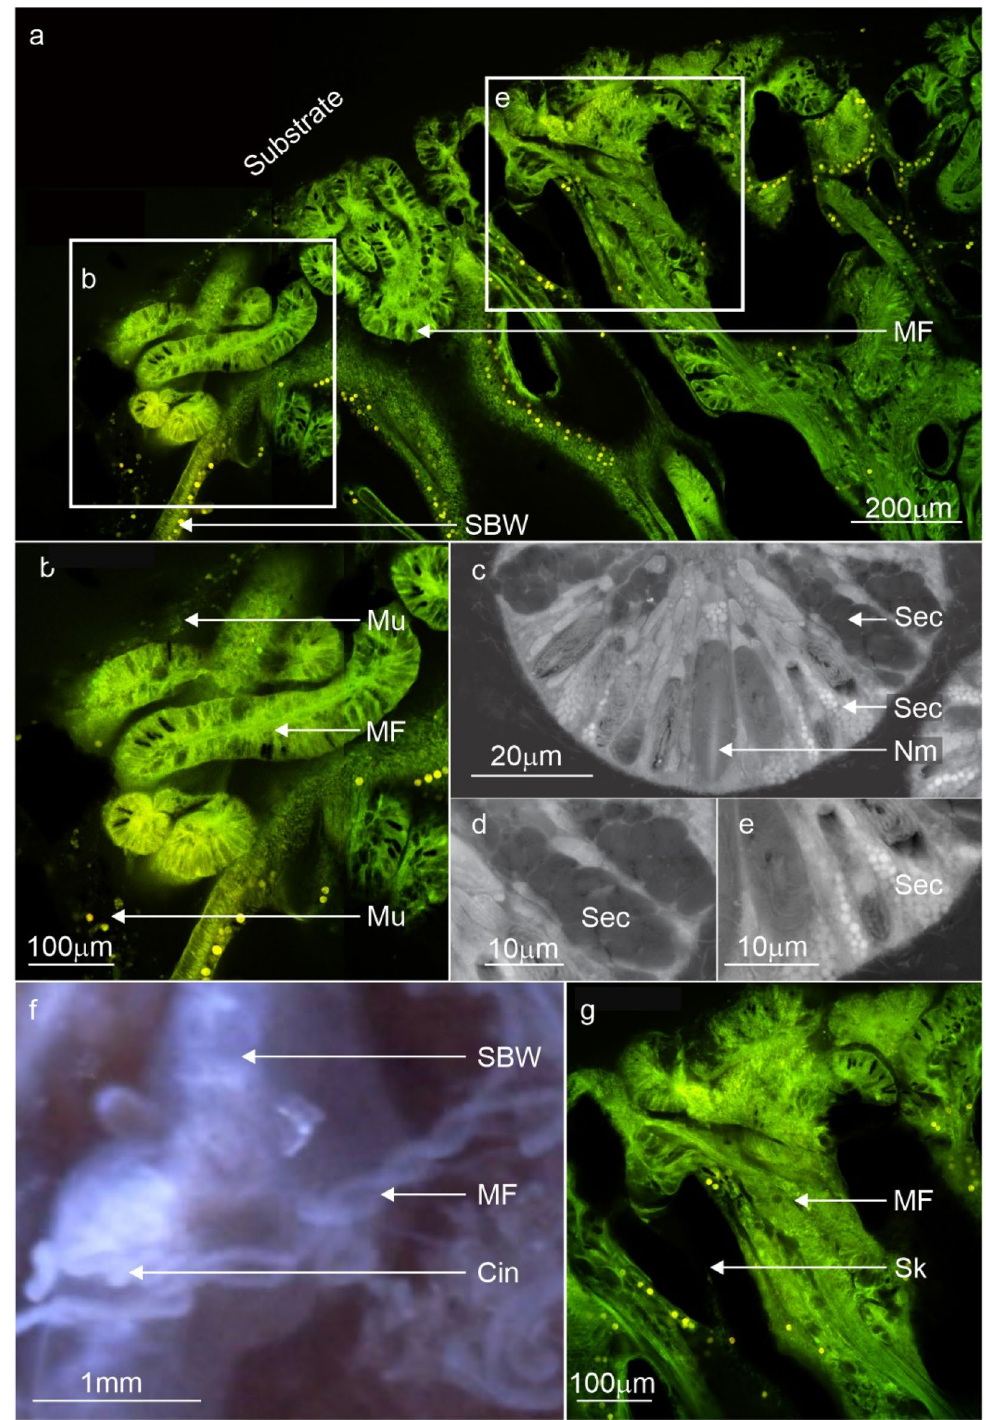
Figure 3. Confocal fluorescence microscopy images, backscatter electron microscopy images and stills from time-lapse microscopy movies highlighting the distribution, cell composition and mesenterial behaviour during the contact response phase. ( a , b ) Contact with the substrate lead to the deployment of mesenterial filaments (MF) in newly formed wounds and the formation of a mucus barrier. ( c – e ) A diverse number of secretory cells (Sec) were present in the mesenterial filaments of A. millepora , and their proximity to the wounds and mucus indicates a role in cleaning and mucus formation. ( f ) For mesenterial filaments to move through the SBW and extend beyond the body cavity, they employ a twisting or corkscrewing motion to slide out of the cinclide- like (Cin) openings (Supplementary Movie S2). ( g ) Fluorescence image of the mesenterial filament (MF) twisting through the cinclide-like structure and the costae (Sk). surface body wall; SBW, mucus layer; Mu, Nm; nematocyst, Skeleton;